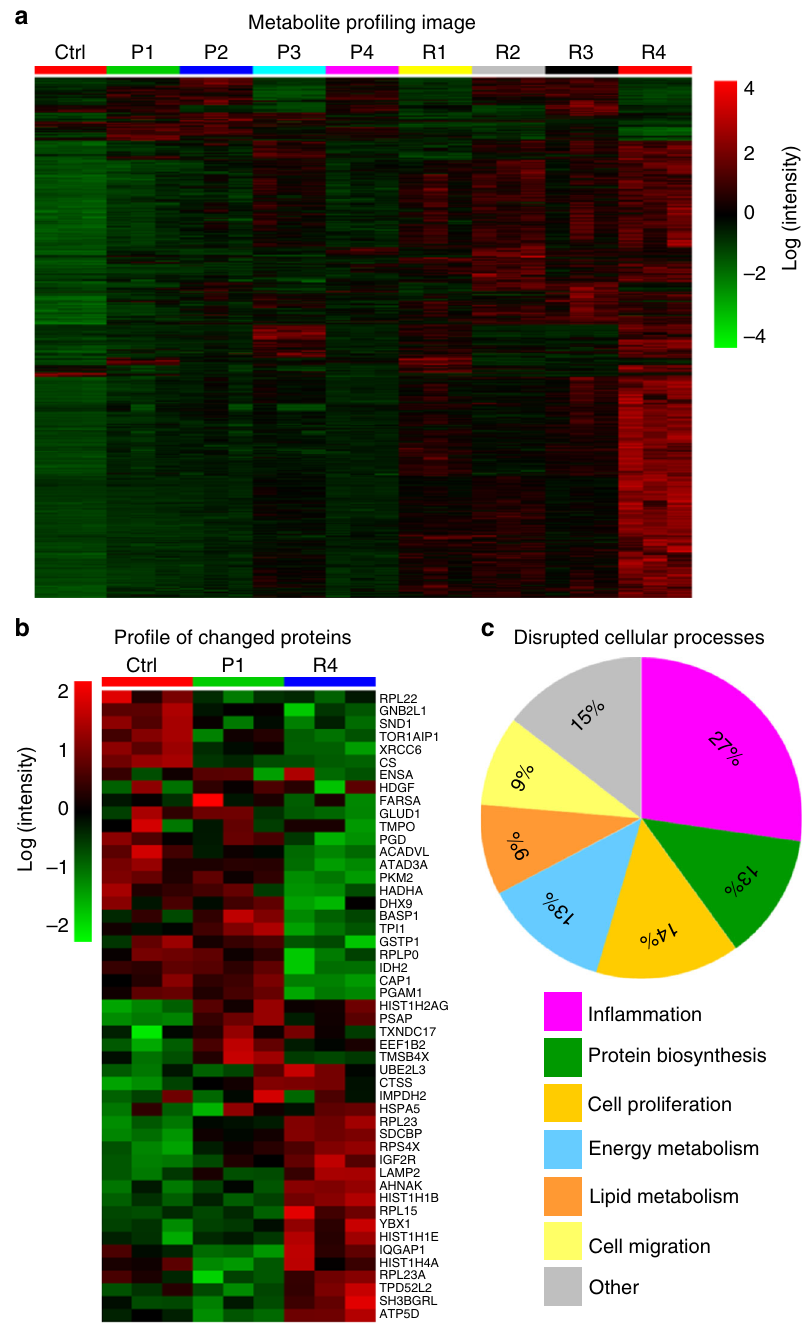
Fig. 2 Fe 2 O 3 induced metabolomics and proteomics changes and relationship. a Metabolite pro fi le of THP-1 cells exposed to Fe 2 O 3 library. After 24 h treatment, the cell samples ( n = 3 independent experiments) were collected to extract proteins and metabolites. For metabolomics analysis, the log- transformed normalized peak intensities of metabolites in all the cell samples were expressed using red, black, or green colors in a heat map. b Fe 2 O 3 nanoparticle-induced protein expression changes. For proteomics analysis, a heat map was plotted in a similar way as metabolites, showing 49 signi fi cantly changed proteins in proteomics analysis. c The pathways or bio-effects related with these proteins were determined by KEGG and UniprotKB database. The percentages of the differential proteins involved in each speci fi c bio-effects of Fe 2 O 3 were shown in the pie